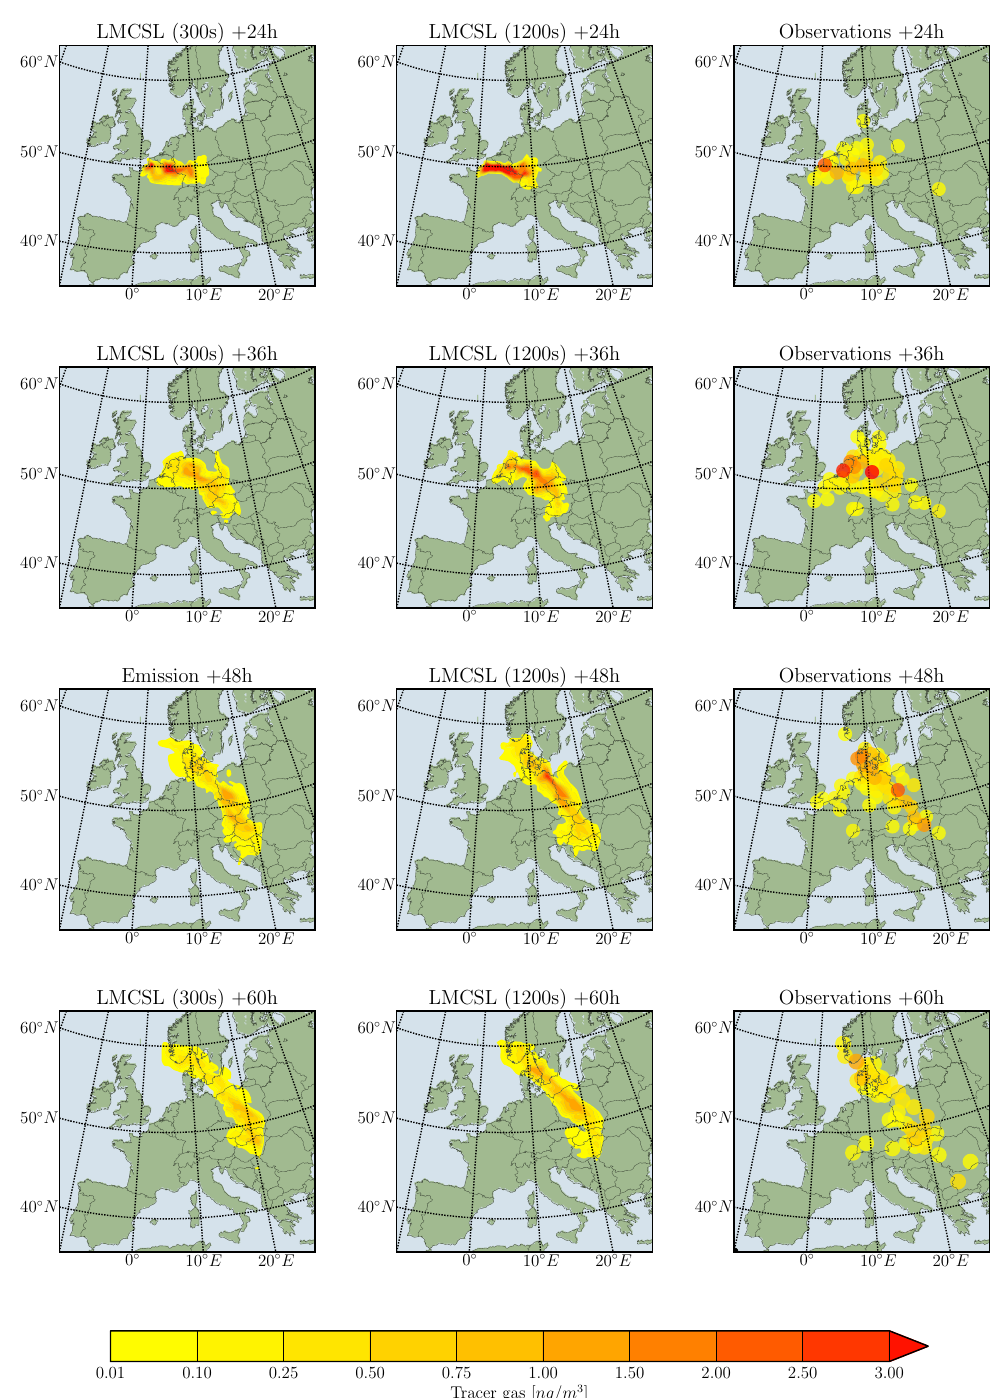
Fig. 6. Emissions with large Courant numbers using the ETEX-1 campaign. The left column shows the simulation using a short time step of 300s (CN 6 1.3), the centre column shows the simulation using a long time step of 1200s (CN 6 5.0), and the right column shows the observations from the original